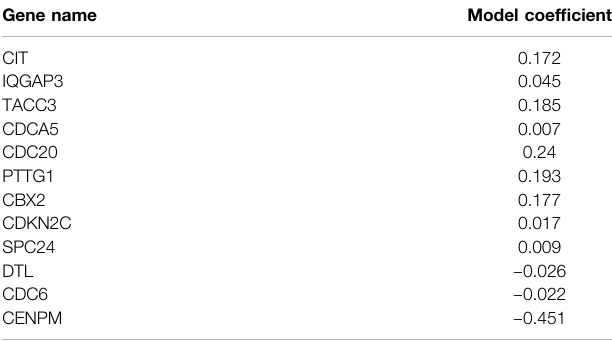
TABLE 3 | LASSO coef fi cients of genes in